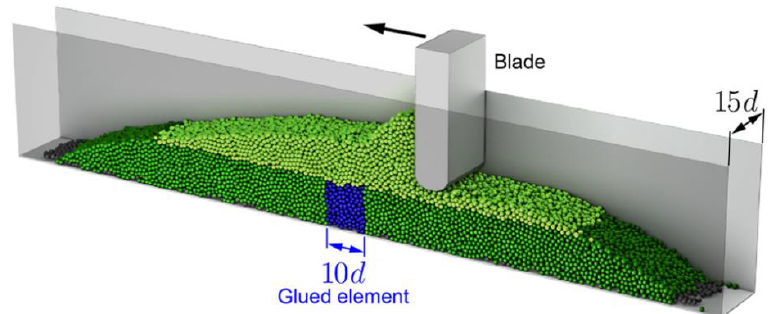
Figure 6. Discrete Element model of powder bed and blade powder spreading [45].